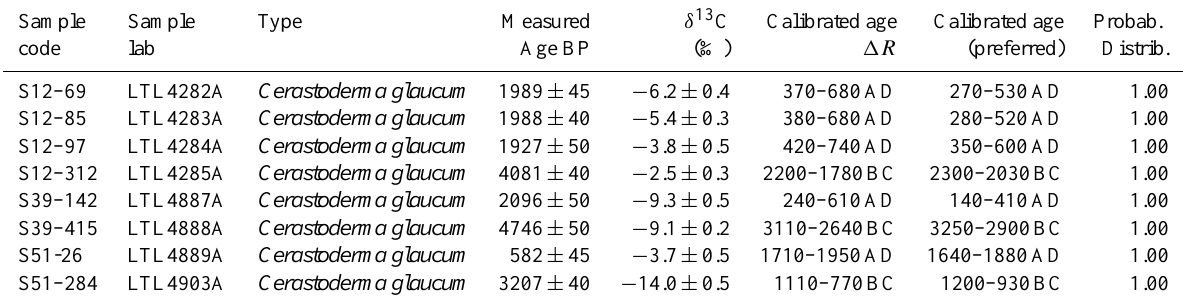
Table 2. Measured and calibrated ages (according to Calib REV5.0.2 by Stuiver and Reimer, 2005; 2 σ value) of the samples collected in the cores. Sample code indicates the core number and depth in cm. The Table shows the calibrated ages resulting by using both the difference 1R = 124 ± 60yr in reservoir age and the correction for marine samples (400yr according to the calibration dataset marine04.14c, see Calib REV6.0). The last column shows the relative area under probability distribution (a value of 1.0 means that the age interval includes 100%